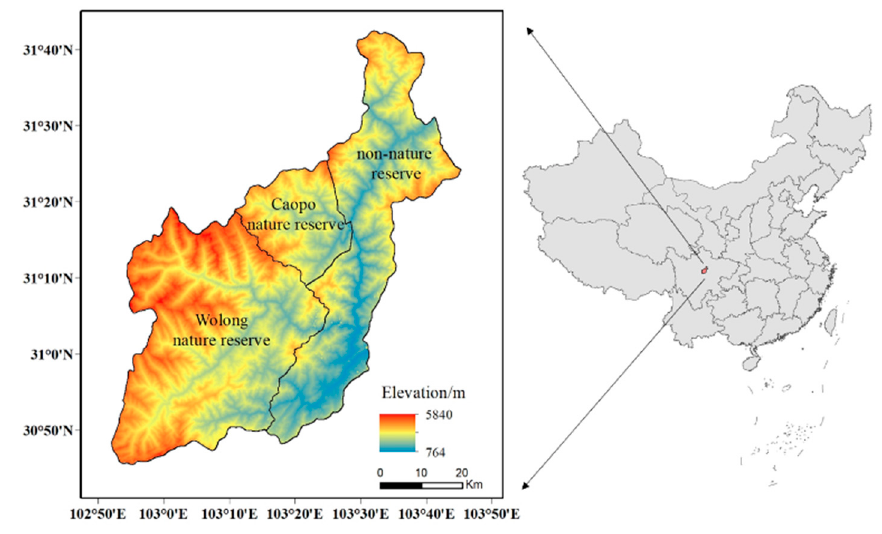
Figure 1. The location of Wenchuan.